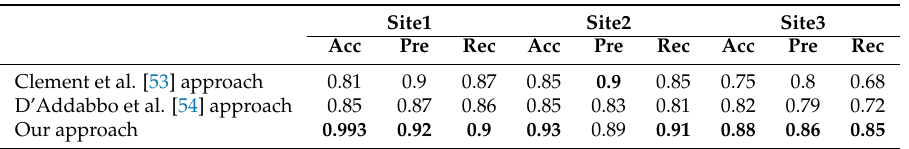
Table 3. Results obtained using our evaluation